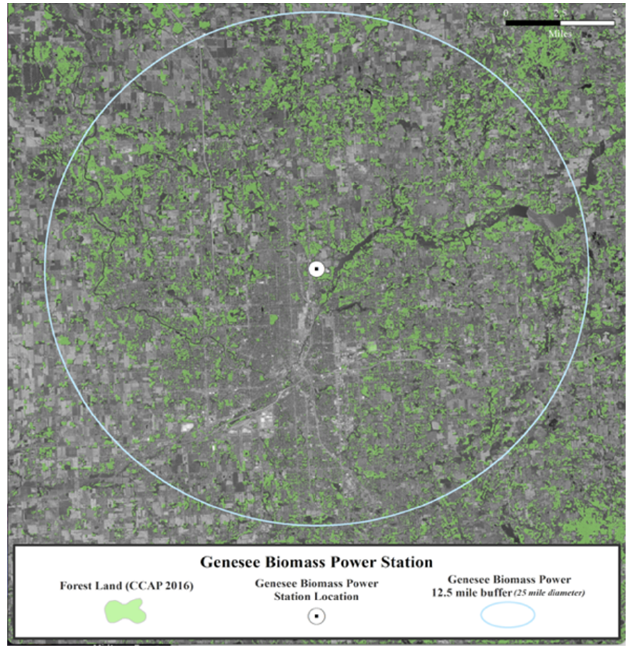
Figure 8. Forest land cover near the Genesee Power Station, Genesee County, Michigan.